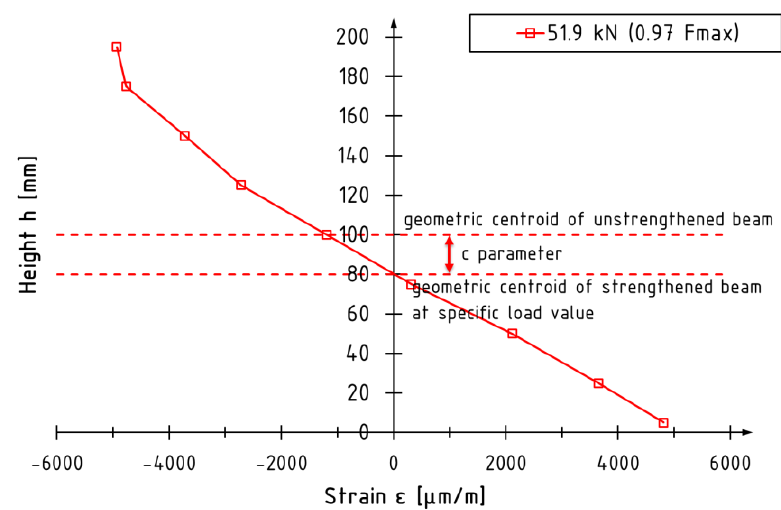
Figure 5. Position of neutral axis at specific load value.